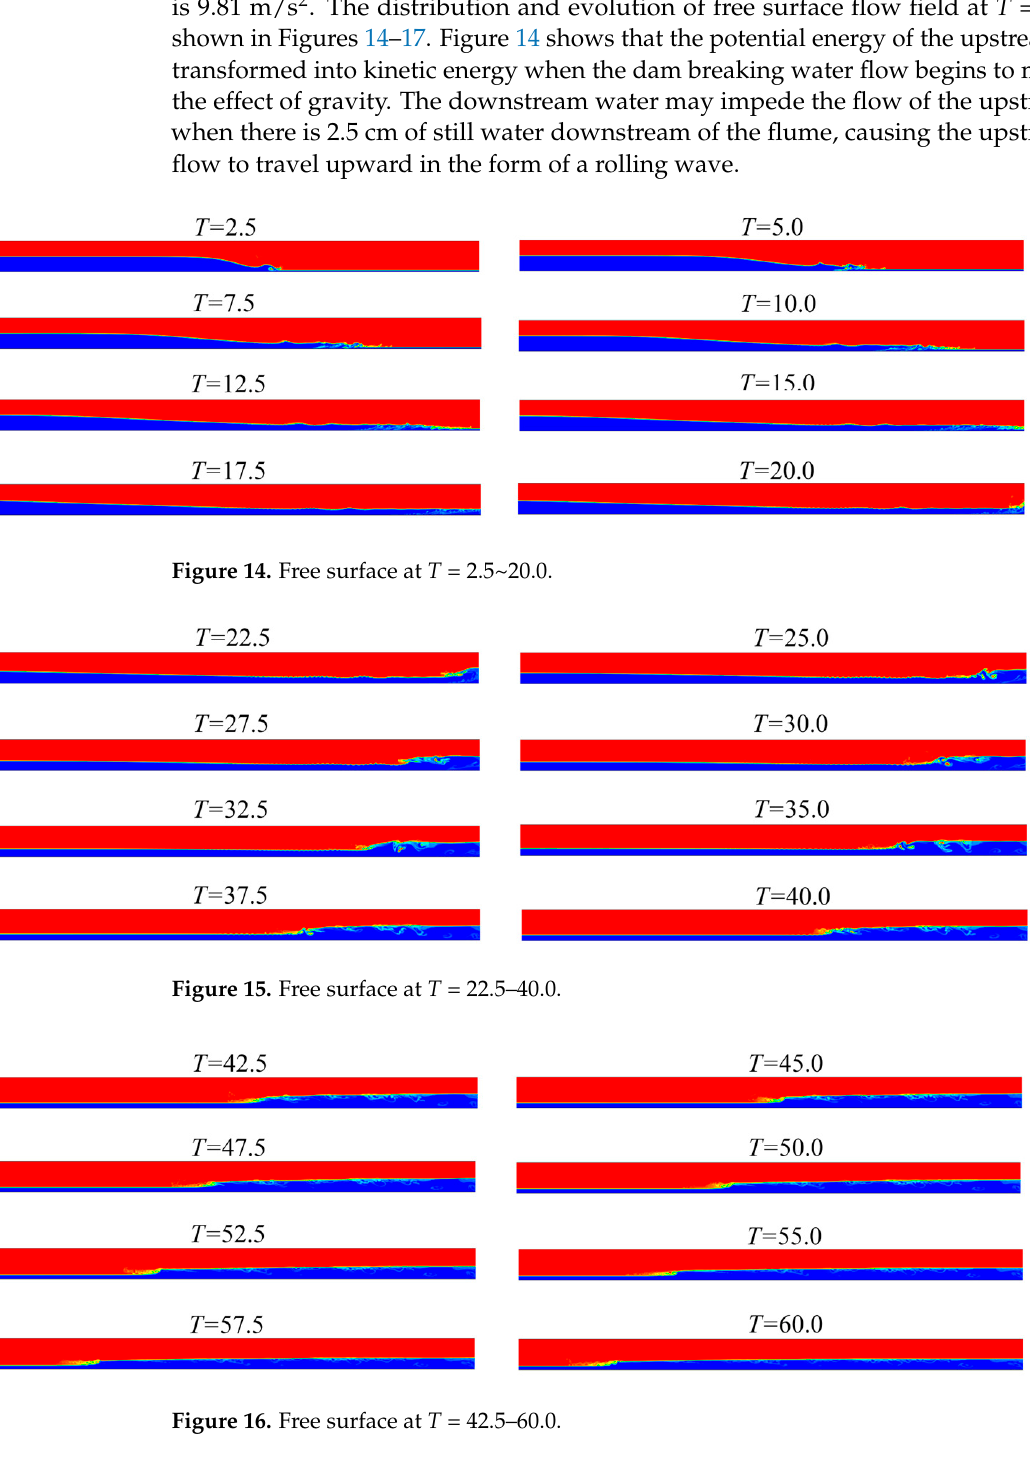
Figure 17. Free surface at T = 62.5–80.0. 4.4. Free Surface Height Variation at Di ff erent Positions Figure 18 depicts the time-varying curve of water level at six positions. The ordinate represents the ratio of instantaneous height h to the maximum height h 0 , while the abscissa represents dimensionless time T . In general, the calculated values of water level at the six locations are in good agreement with the experimental values. As the dam break wave reaches the area, the water level at other regions will increase swiftly and remain constant for a long time. The position of P2 is the closest to the upstream water column, so the height of free surface here will rise rapidly after the dam break begins, and then the water level will remain constant before T = 33 and maintain at about h/h 0 = 0.43. The water levels of P1 and P2 gradually decreased between T = 32–48 and T = 33–46, respectively, and then rose rapidly to the peak. The second rapid rise in the free surface water level at each loca- tion is caused by re fl ected waves generated by the re fl ection of the dam break wave against the downstream right wall.